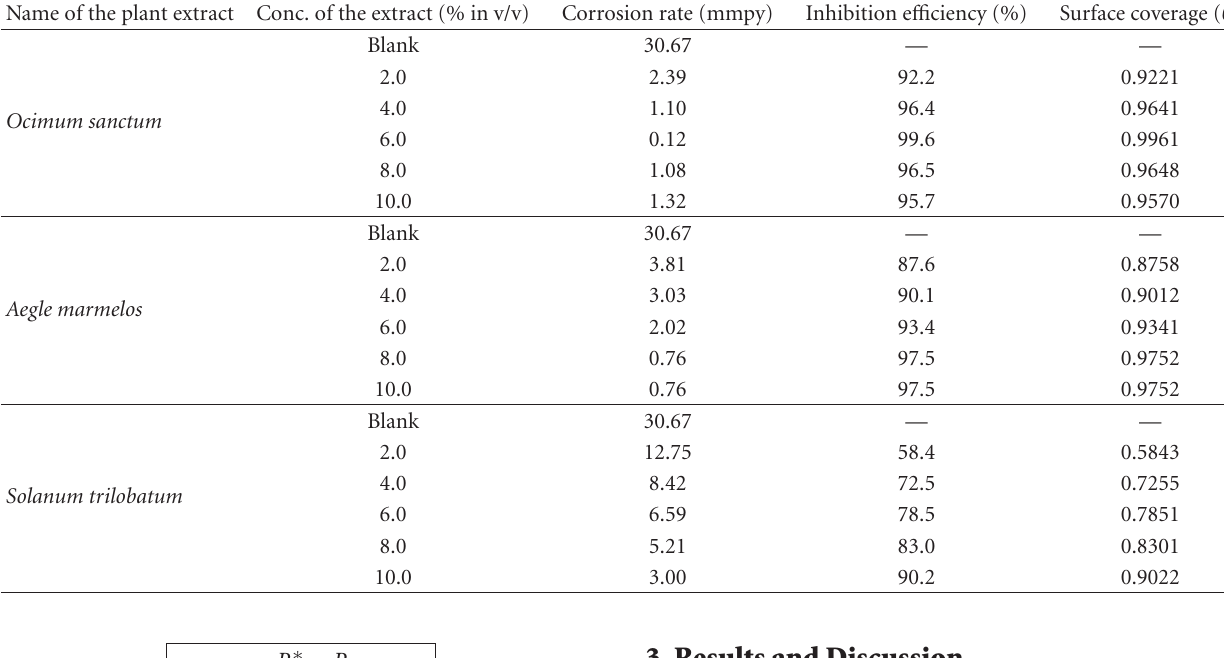
Table 1: Corrosion parameters obtained from weight loss measurements for mild steel in 1N HCl containing various concentrations of the plant